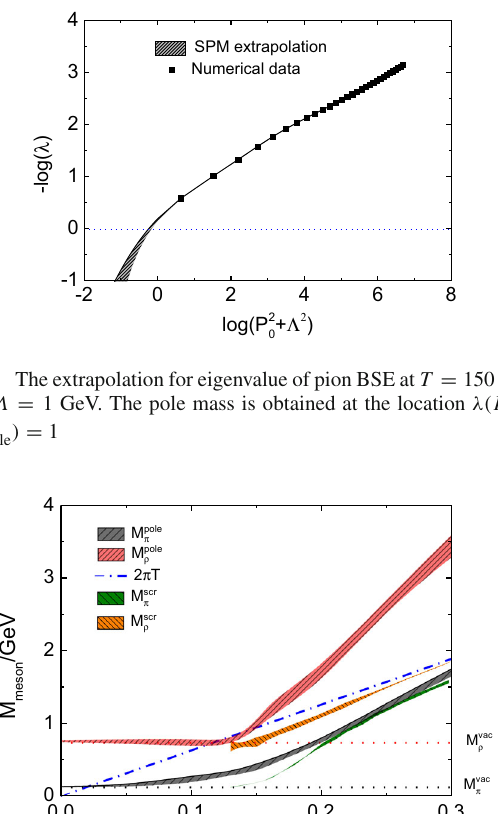
Fig. 2 Pole masses of π ( black ) and ρ ( red ) meson at finite tempera- ture as well as the free field limit of screening mass ( dash-dotted curve ) M scr ∼ 2 π T . The bands mark the domain of the results obtained using SPM extrapolation. The π and ρ mass in vacuum, M v ac π and M v ac ρ , are included to guide comparison. The screening mass for π ( oli v e ) and ρ ( orange ) mesons are from lattice QCD (lQCD) [21]